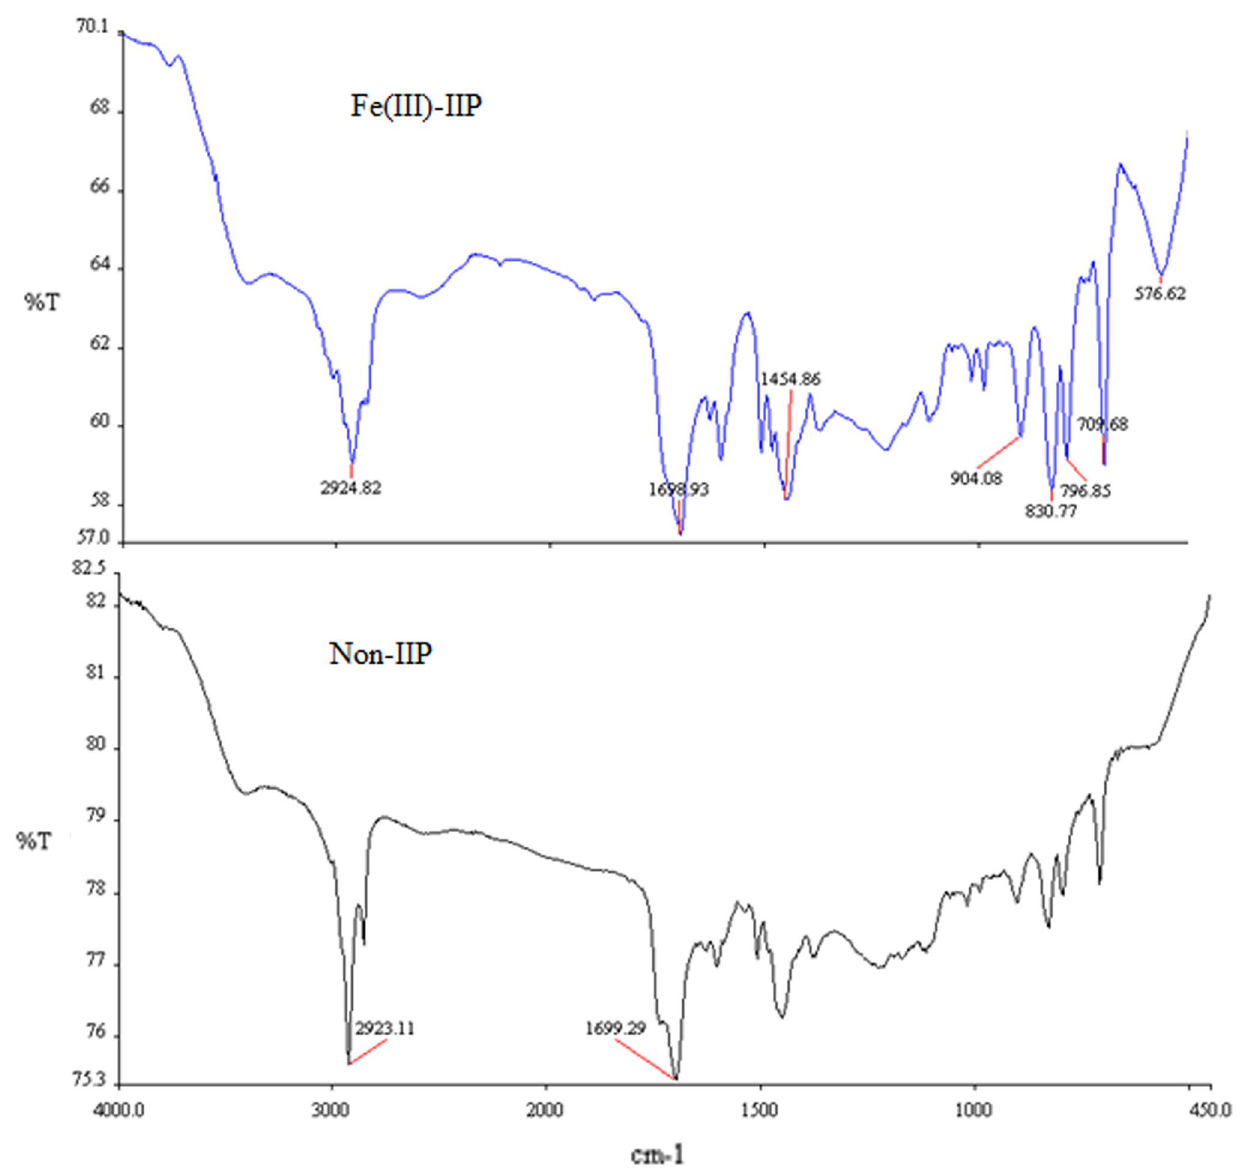
Fig. 6 Fourier transform-infrared spectra of Fe(III)-IIP and